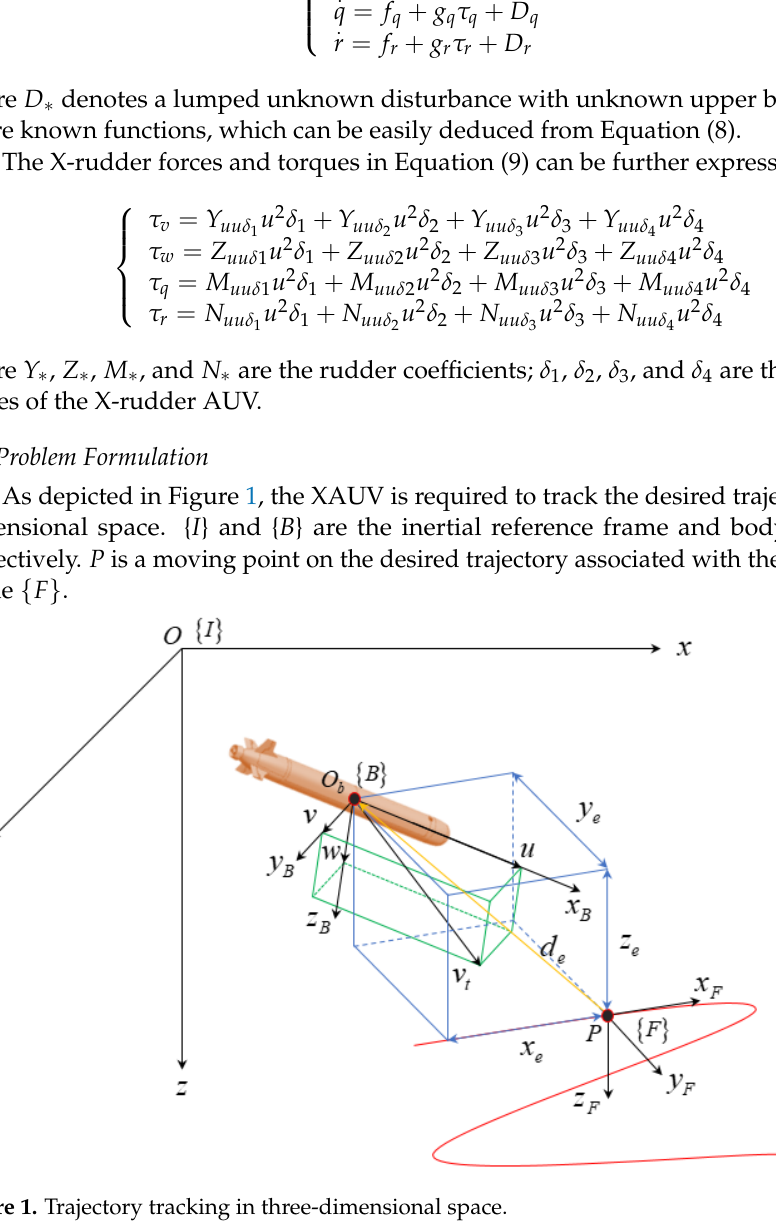
Figure 1. Trajectory tracking in three-dimensional space.